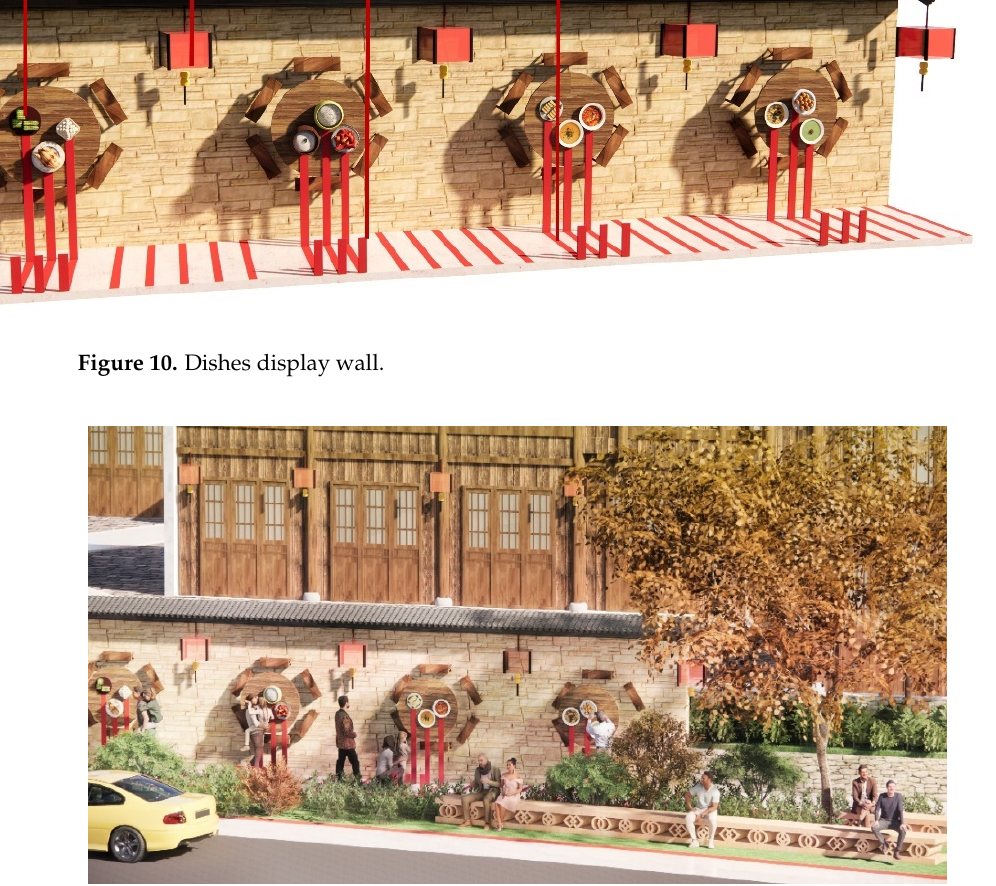
Figure 11. Hundred-family Feast food culture experience zone landscape space.